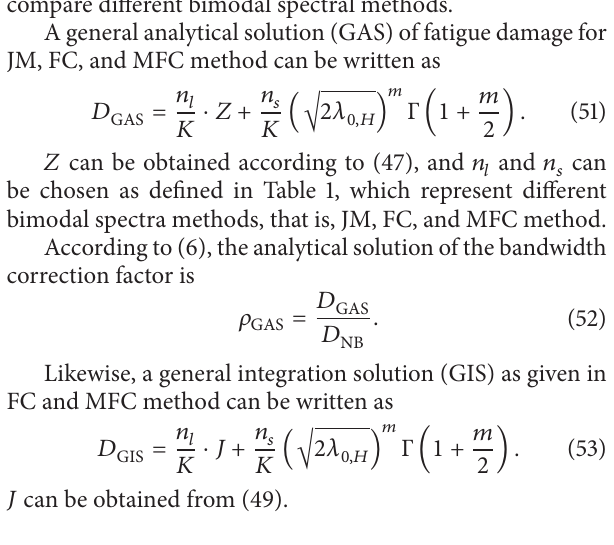
FC’s numerical integral solution for (49)